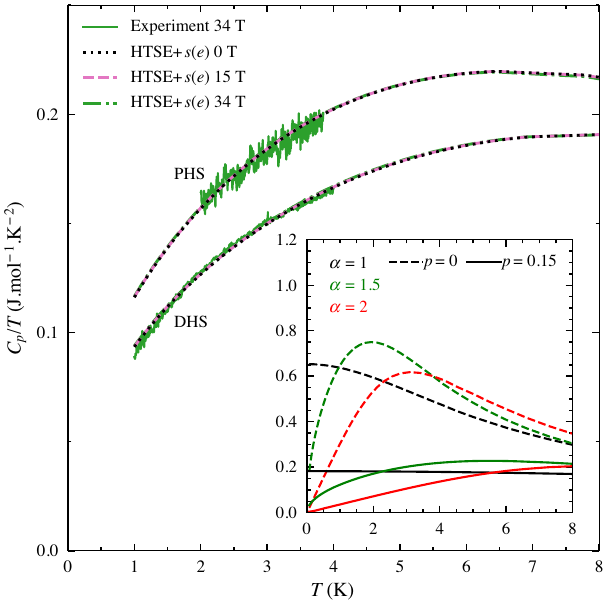
=T data at 34 T compared to the HTSE þ s ð e Þ FIG. 3. The C p results, which are field independent from 0 to 34 T. In the inset, we show the drastic impact of α and p values on the shape and magnitude of the specific heat curves. The experimental data are only reproduced if we use a power α ∼ 1 . 5 and impose a dilution p ∼ 10% – 15% .